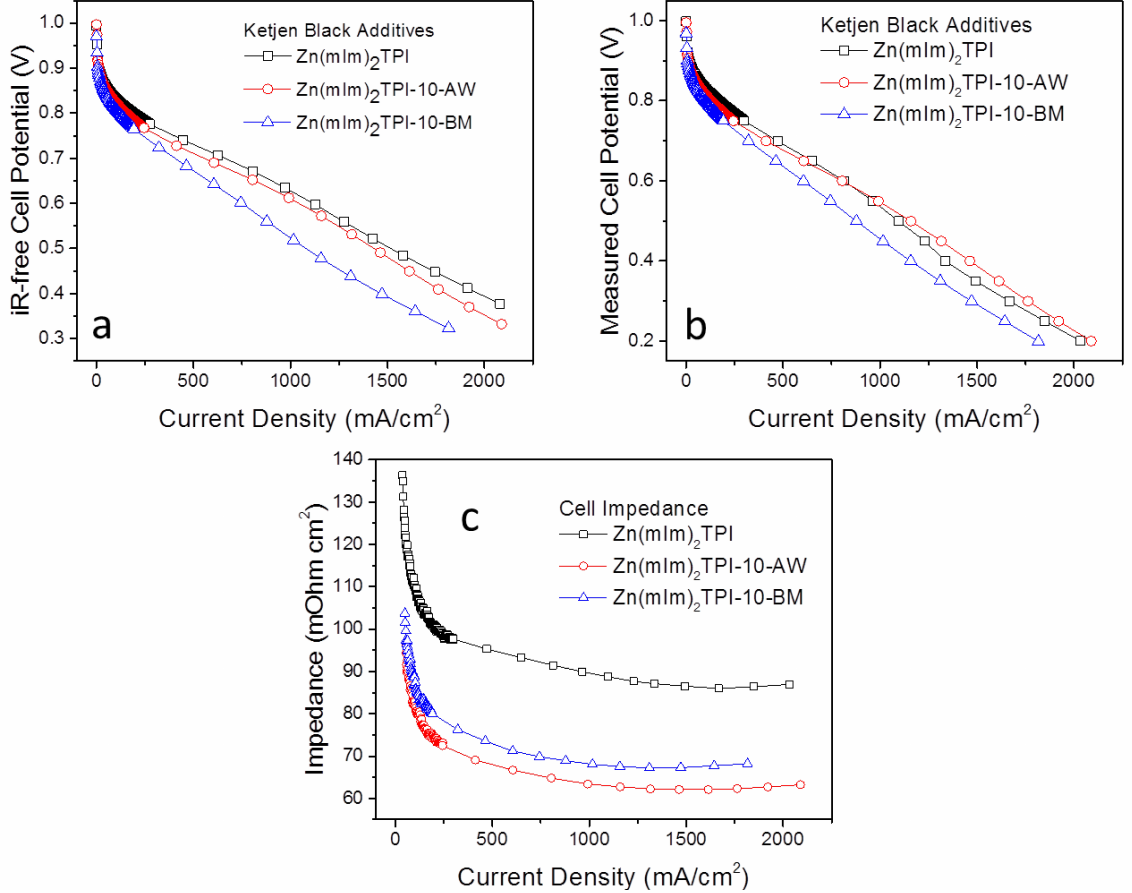
Figure 2. ( a ) Impedance corrected polarization curves from Ketjen Black additives and a control sample without any Ketjen Black. ( b ) Polarization curved without impedance correction from Ketjen Black additives and a control sample without any Ketjen Black. ( c ) Cell impedance curves corresponding to polarization curves shown in ( a ) and ( b